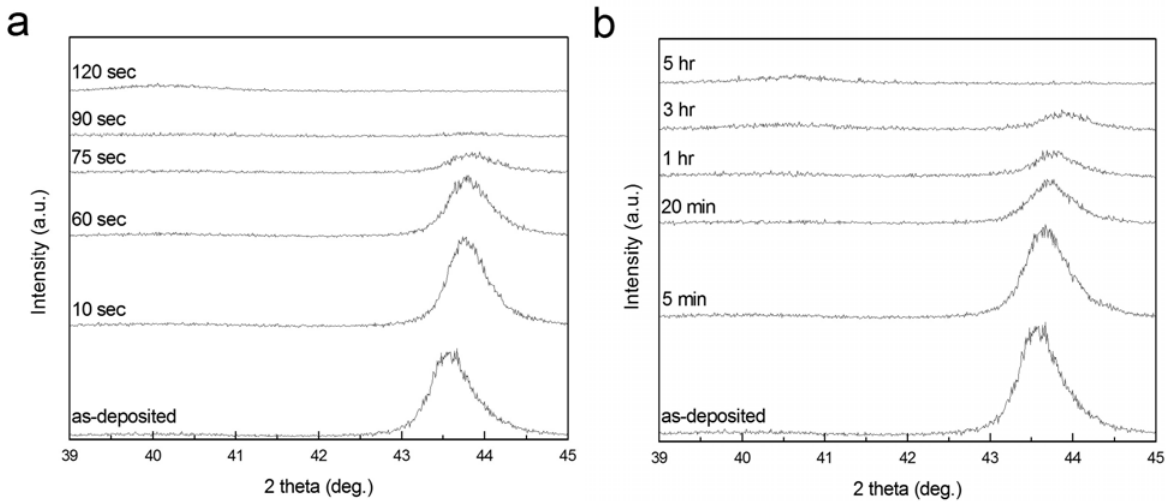
Figure 4. Evolution of 90 nm PdNi films dealloyed in (a) 98% and (b) 25% sulfuric acid, as tracked by the integrated intensity of the PdNi alloy peak at ~43.6° in XRD patterns. During dealloying, the PdNi peak shifted to progressively higher angles, perhaps due to changes in film stress. In XRD scans of both films at long dealloying times, a low, broad peak observed near the expected Pd position of 40.1° is likely due to